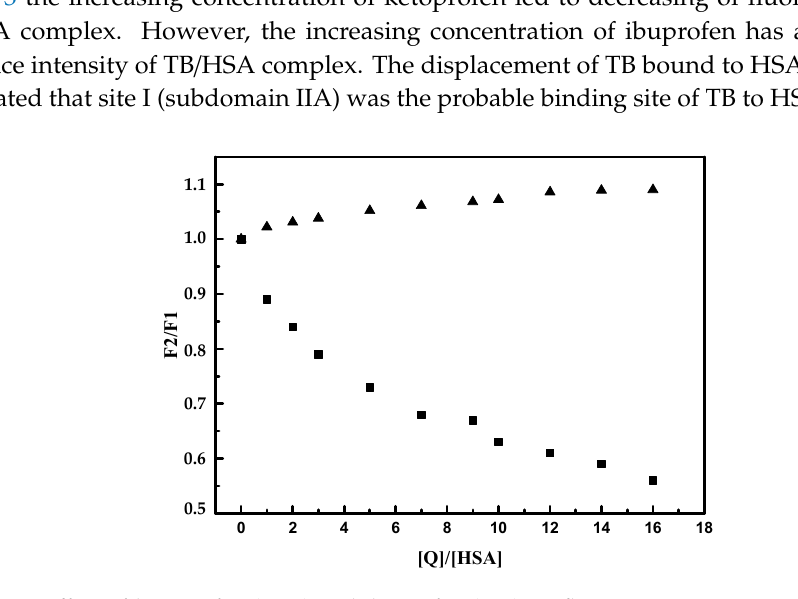
Figure 3. E ff ect of ketoprofen (KTF) and ibuprofen (IBF) on fluorescence intensity of the TB / HSA Figure 3. Effect of ketoprofen (KTF) and ibuprofen (IBF) on fluorescence intensity of the TB/HSA system; c (TB) = c (HSA) = 2 × 10 − 6 mol / L; c(KTF) = c(IBF) = 0–32 × 10 − 6 mol / L; [ Q ]: (cid:78) ibuprofen (cid:4) system; c (TB) = c (HSA) = 2 × 10 − 6 mol/L ; c(KTF) = c(IBF) = 0–32 × 10 − 6 mol/L; [ Q ]: ▲ ibuprofen ■ ketoprofen; pH = 7.4; t = 25 ◦ ketoprofen ; pH = 7.4; t = 25 °C.